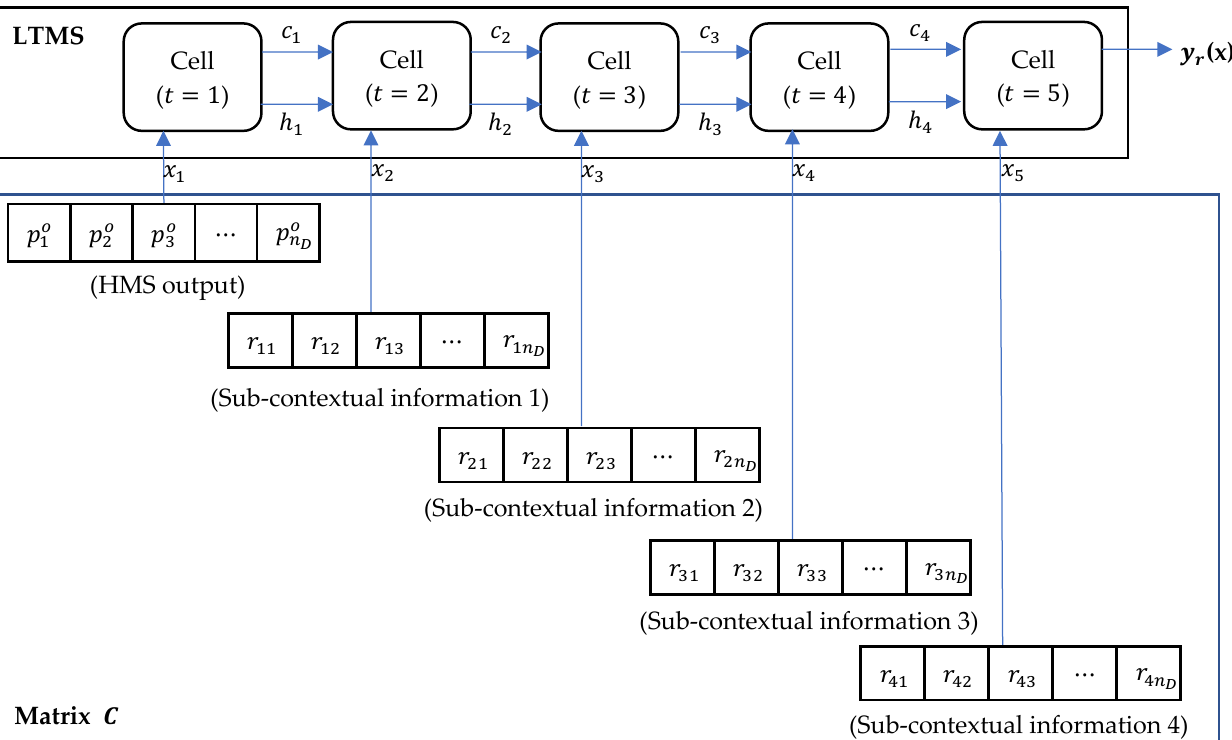
Figure 6. Application of LSTM to LC information recognition. 𝑡 is the timestep; 𝑥 𝑡 , 𝑐 𝑡 , ℎ 𝑡 are the input vector, cell state, and hidden state, respectively, at timestep 𝑡 .